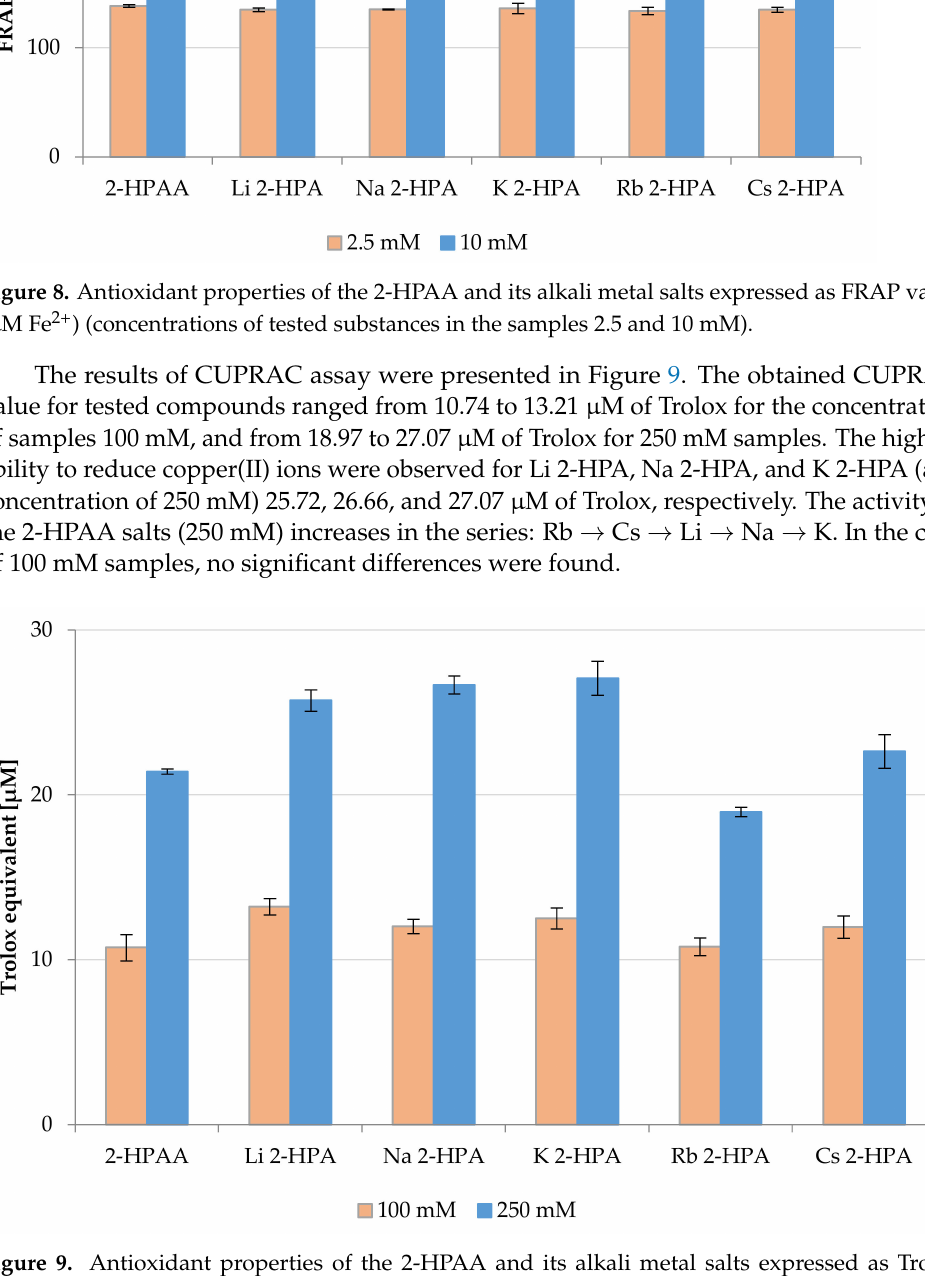
Figure 9. Antioxidant properties of the 2-HPAA and its alkali metal salts expressed as Trolox equivalents ( µ M) (concentrations of tested substances in the samples 100 and 250